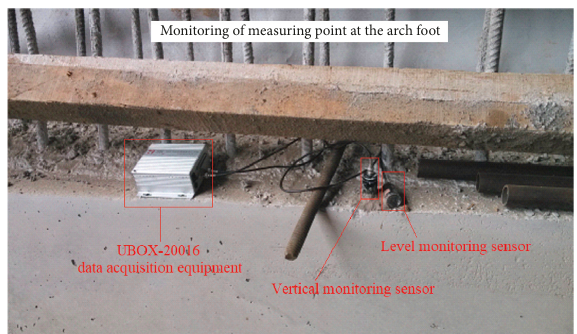
Figure 6: Field layout of instruments and